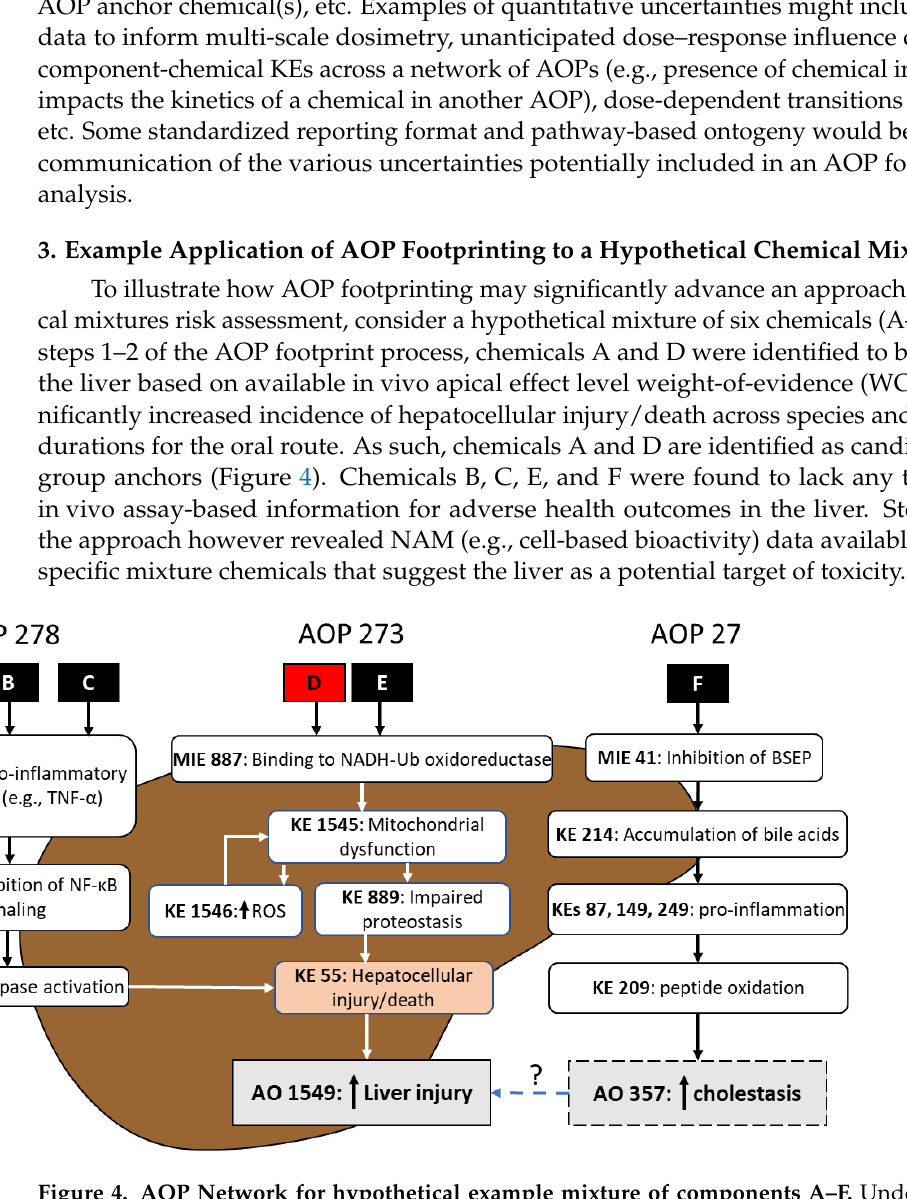
Figure 4. AOP Network for hypothetical example mixture of components A – F. Under step 4 of the AOP footprint process, based on traditional assay and/or NAM (e.g., evidence of bioactivity consistent with key events) WOE across the mixture components, three operant liver AOPs (278, 273, and 27) were identified for the specified health effect (e.g., increased liver injury). Data were also used to confirm selection of AOP anchor chemicals (e.g., mixture components A and D for liver AOPs 278 or 273, respectively) and to support assignment of data-poor components (i.e., chemicals B, C, E, and F) to the appropriate AOP grouping. Under step 5 of the process, an AOP footprint event is identified; in this hypothetical mixture example the liver AOP footprint is ‘KE 55: hepatocellular injury/death’ for both AOPs 278 and 273. Mixture component F is also a potential contributor to liver injury associated with exposure to the mixture however due to lack of AO data and identification of an AOP anchor chemical this component does not move on to step 6.